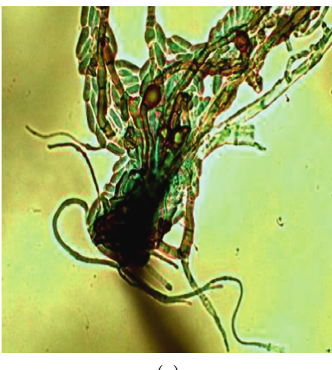
Figure 1: Colletotrichumfructicola isolated from “Ataulfo” mango fruit. (a) Front plate. (b) Reverse plate. (c) Conidia (a) and appressories